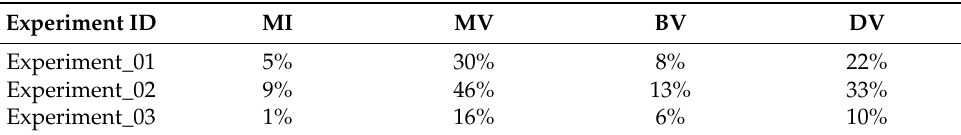
Table 4. The comparison results of algal-bloom recognition in algal-free areas. (MI is the result of manual interpretation; MV is the recognition result using the method described in [31]; BV is the recognition result of this method; and DV is the errors of PA between the method described in [31] and the proposed method).